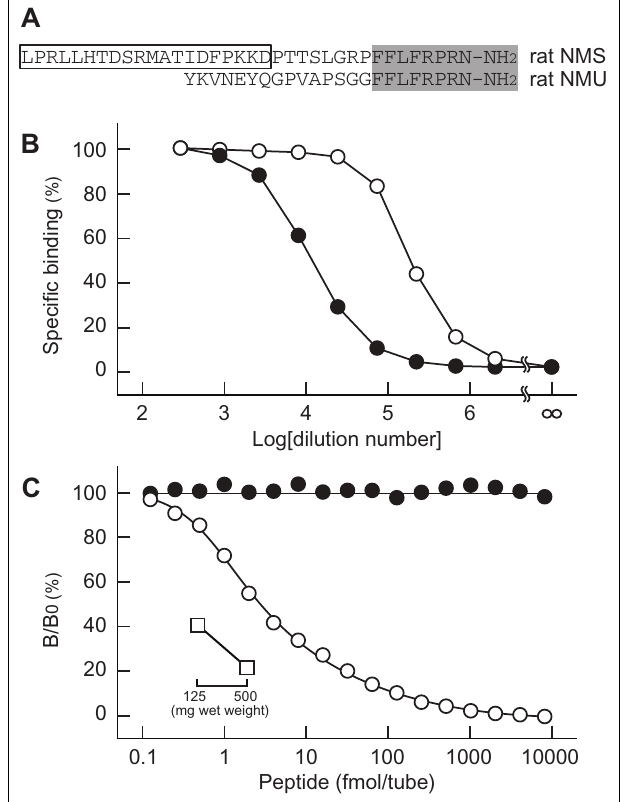
FIGURE 1 | Characterization of antisera for rat neuromedin S (NMS). (A) Structural comparison of rat NMS and rat neuromedin U (NMU). Structure conserved in the two peptides is shaded.The box indicates the sequence used as antigen peptide to obtain antisera specific for rat NMS. (B) Specific binding curves of antisera. [ 125 I-Tyr 21 ]-rat NMS[1-20] was incubated with serially diluted OB1321-1 (closed circles) and OB1321-2 (open circles) antisera, and then co-precipitated with antibody in a concentration-dependent manner. (C) Standard curve of radioimmunoassay for rat NMS using antiserum OB1321-2. [ 125 I-Tyr 21 ]-rat NMS[1-20] binding to antibody was displaced by increasing concentrations of rat NMS (open circles) but not rat NMU (closed circles). B/B0 means tracer bound/tracer bound in zero standards. Inset shows the inhibition of tracer ligand binding to antibody by diluted rat brain extract (open